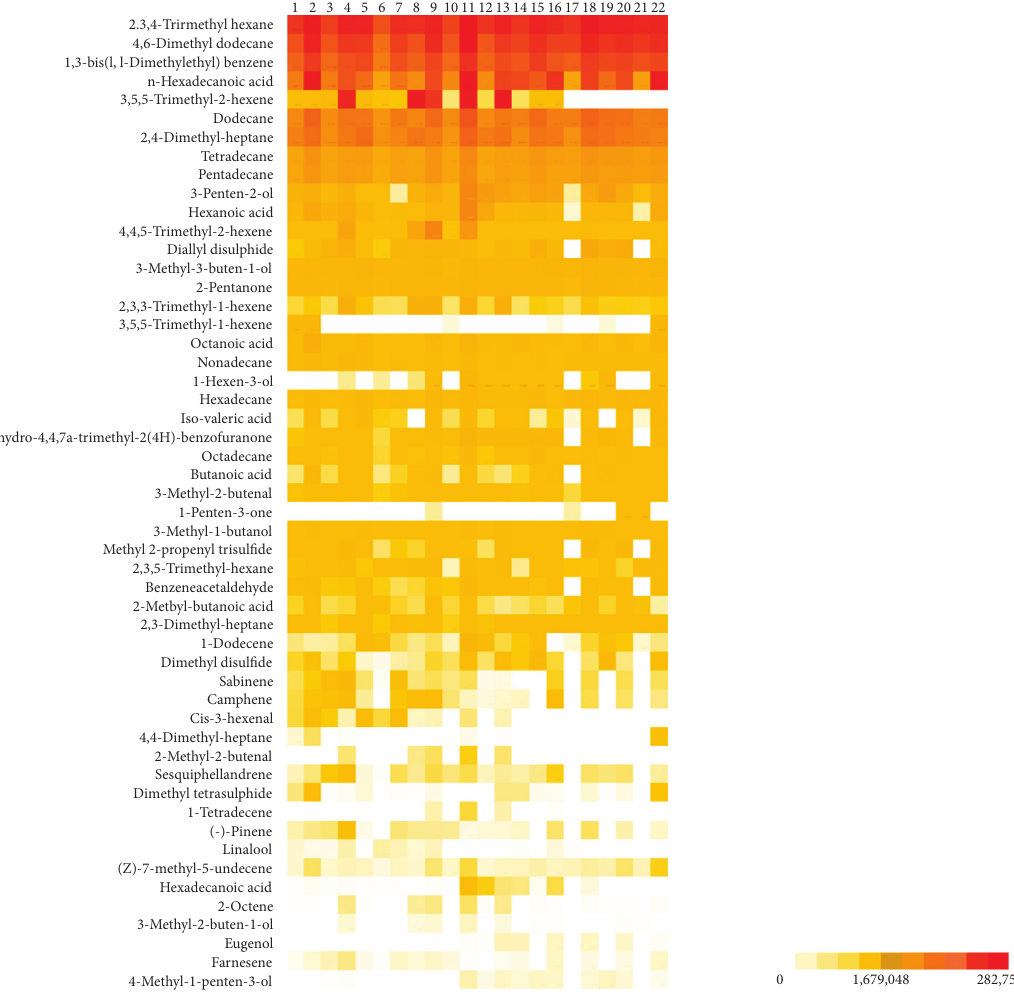
Figure 4: Heat map of volatile organic compounds (VOCs) in